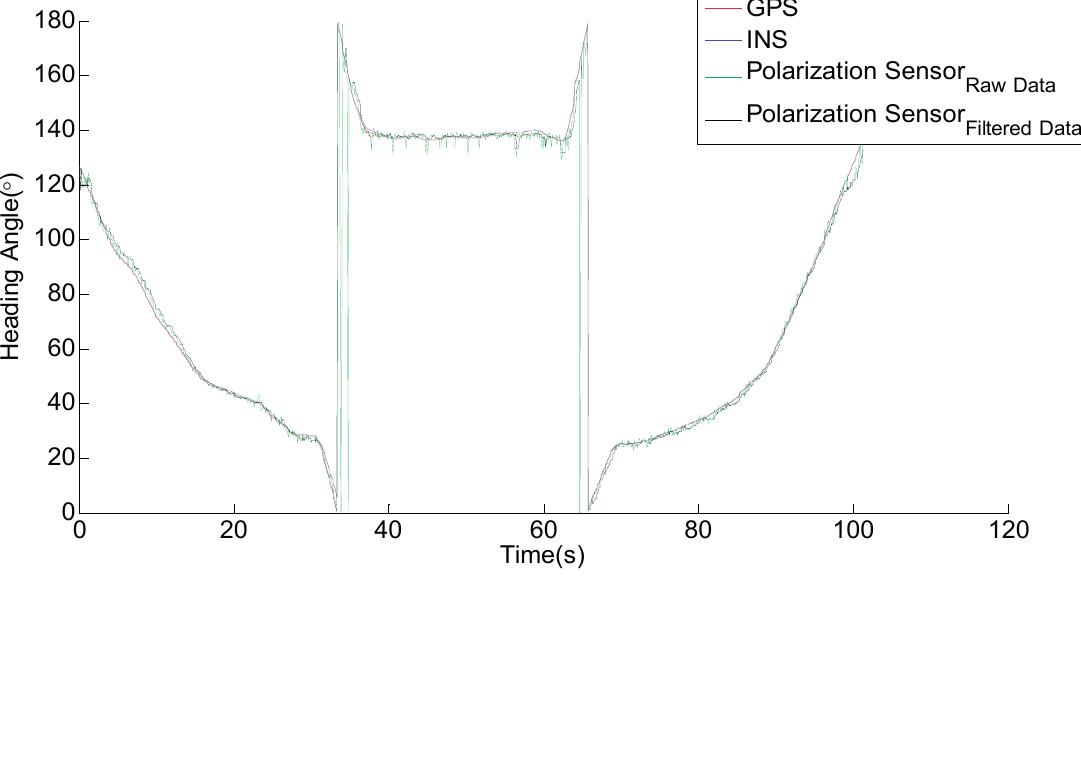
Figure 12. GPS, INS and the filtered result of the polarization